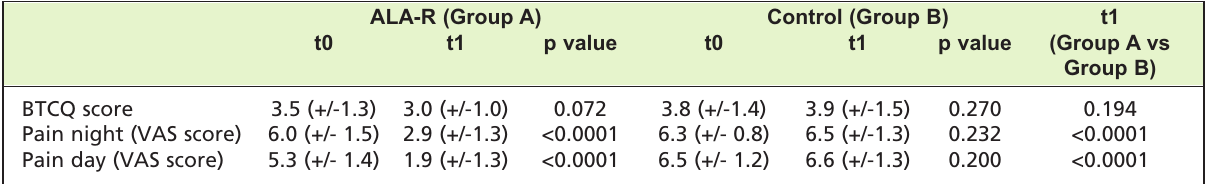
The results. Data represent the mean +/- Table III: